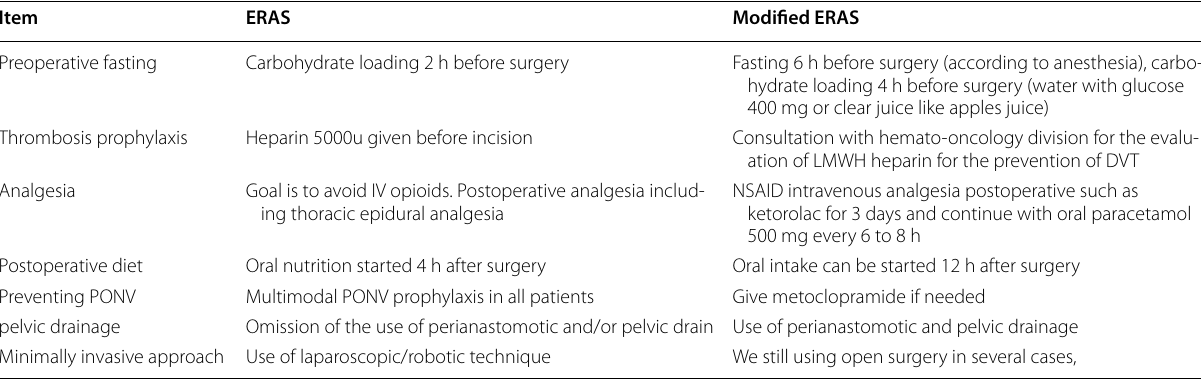
Table 2 Difference between ERAS and modified